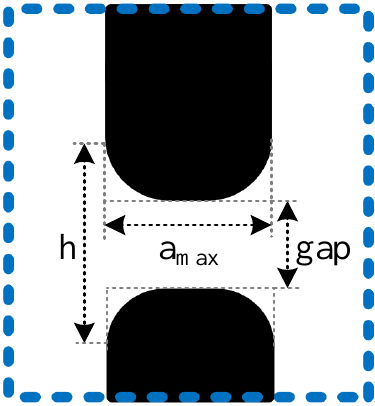
Figure 10. The parameters that SEM needs to measure.